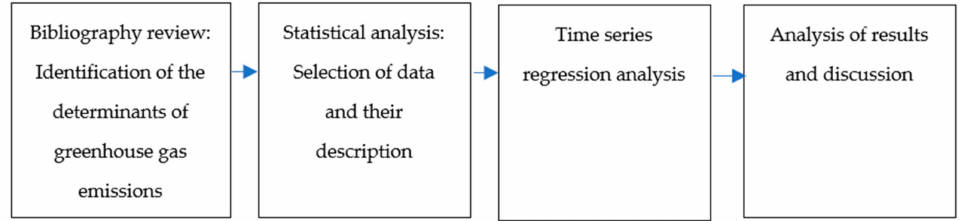
Figure 2. Methodological framework. Source: own study.